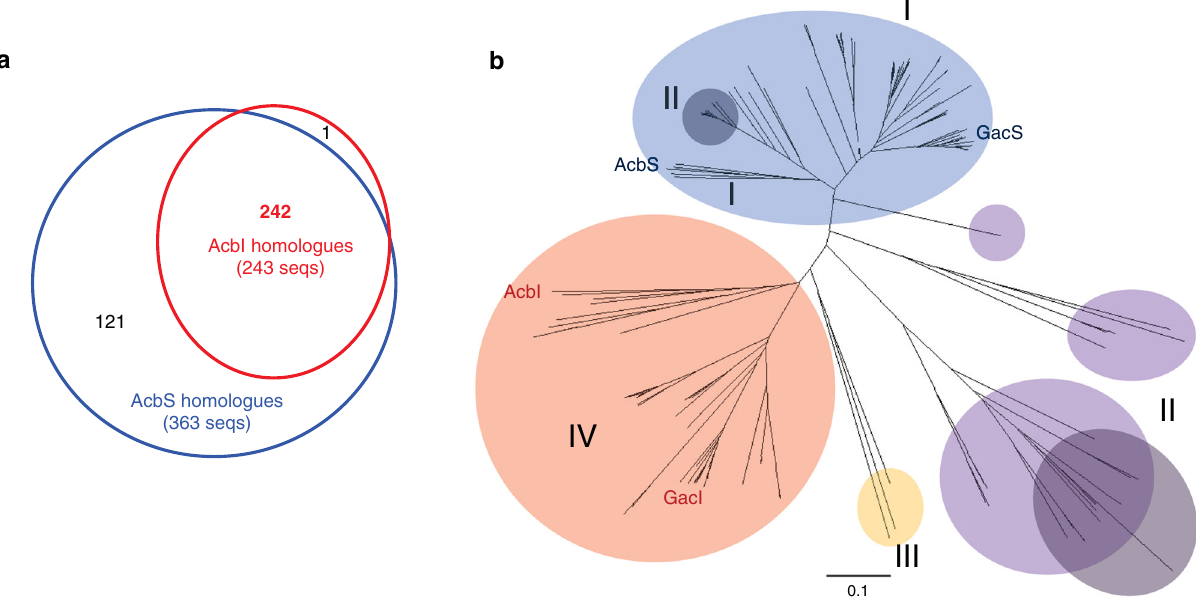
Fig. 5 Homologues of AcbI and AcbS. a Homology searches for AcbI and AcbS; b Phylogenetic tree of AcbI and AcbS. The ones shaded in blue are predicted to be AcbS homologues (PsGTs). The ones shaded in red are AcbI homologues (GTs). The ones shaded in dark blue are AcbS whose genes do not have an AcbI partner gene within a biosynthetic gene cluster (BGC). The ones shaded in purple do not pair with another AcbI/AcbS homologue in a BGC. The ones shaded in dark purple are AcbI/AcbS homologues whose genes are part of a BGC that lacks an aminotransferase gene. The ones shaded in yellow are AcbI/AcbS homologue whose genes are part of a BGC that does not contain cyclitol biosynthetic